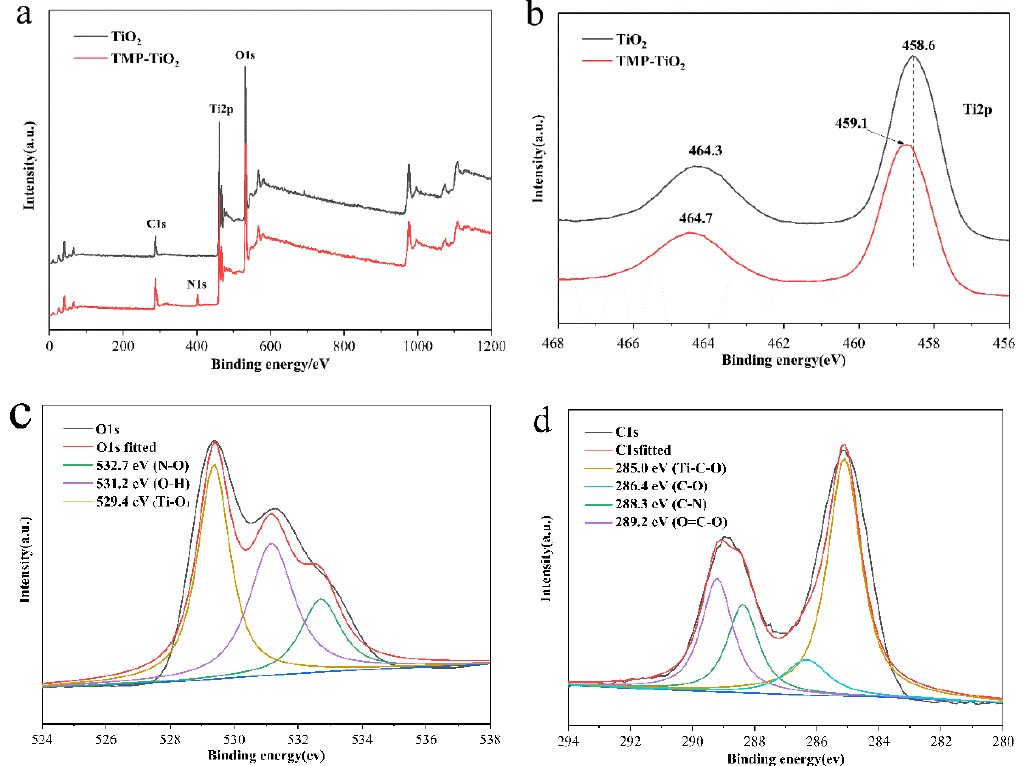
Figure 3. ( a ) XPS of unmodified TiO 2 and TMP-TiO 2 , ( b ) Ti2p XPS high resolution spectra of unmodified TiO 2 and TMP-TiO 2 , ( c ) O1s XPS high resolution spectra of TMP-TiO 2 , and ( d ) C1s XPS high resolution spectra of TMP-TiO 2.